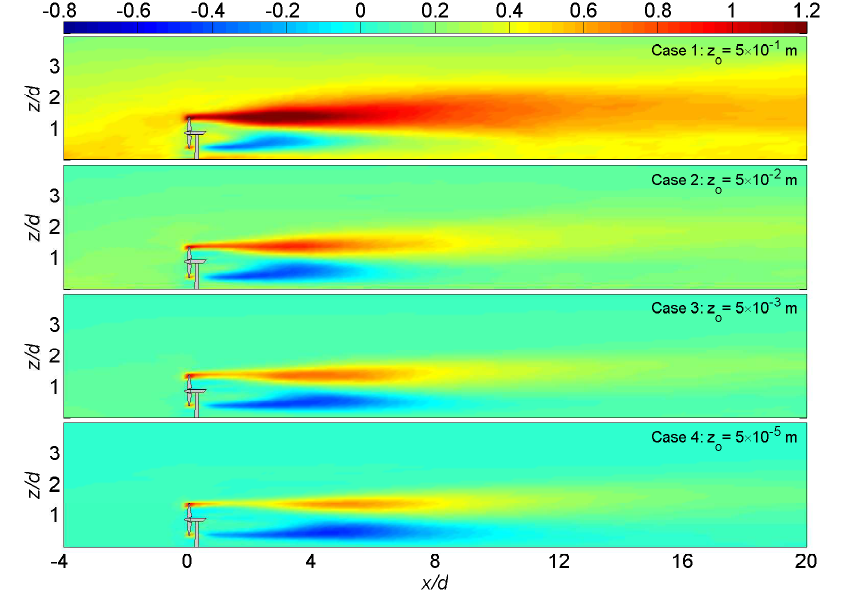
Figure 9. Contours of the kinematic shear stress τ perpendicular to the turbines installed over flat surfaces with different roughness